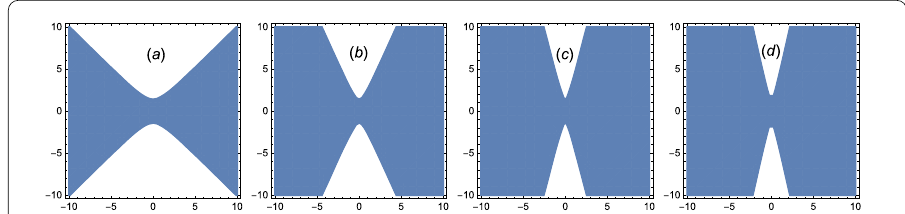
Figure 5 Regions of stochastic stability of (34) for c = –1 in a ( σ , b )-space of parameters